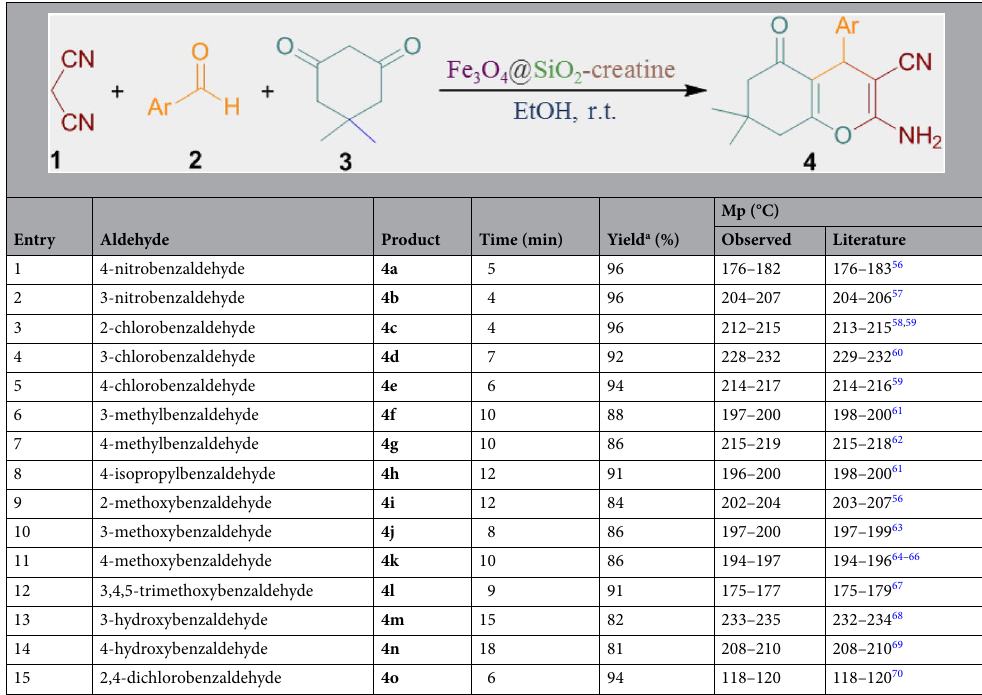
Table 3. Synthesis of 2 ‐ amino ‐ 4 H ‐ chromene derivatives using creatine-based catalyst. a Isolated yields.